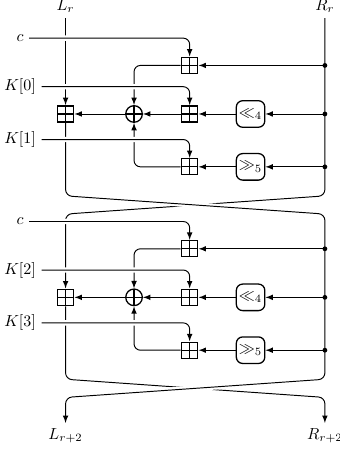
Figure 1: Round function of the